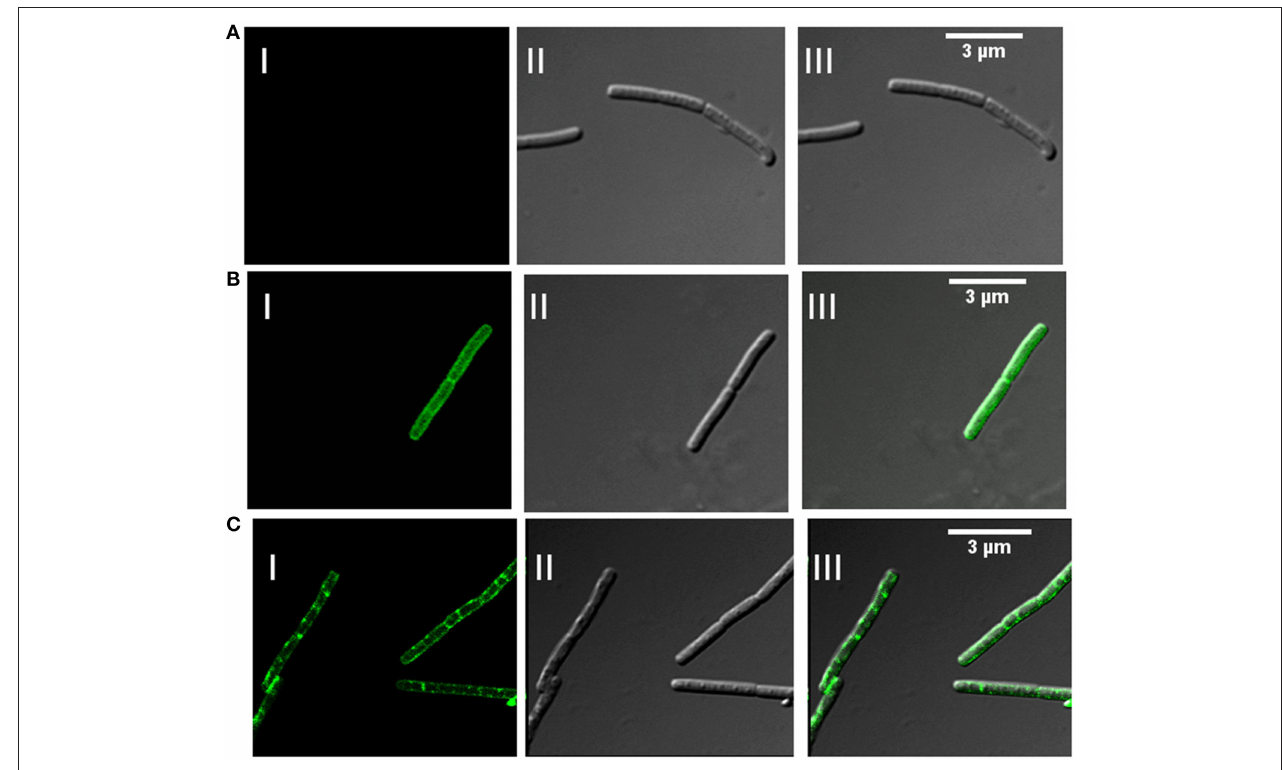
FIGURE 5 | Heterogeneous distribution of FlotP on membrane of B. anthracis by indirect immunofluorescence analysis using Confocal microscopy. (A) B. anthracis cells with pre-immune sera, (B) homogenous distribution of GroEL over the surface of bacteria with anti-rGroEL antibody, and (C) heterogeneous distribution of FlotP with anti-rFlotP antibody. Images were captured at 100X magnification and zoomed twice for final images. Anti-mouse IgG-FITC antibody was used as secondary antibody. In each Figure, panels I, II, and III represents FITC channel, DIC channel, and superimposition of panels I and II, respectively.